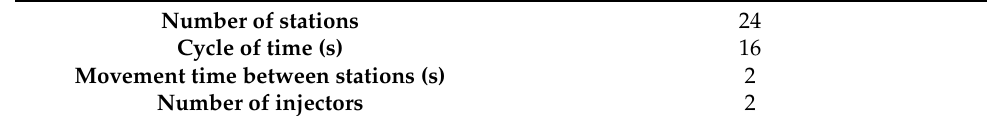
Table 2. Rotary machine features (direct-injection process).